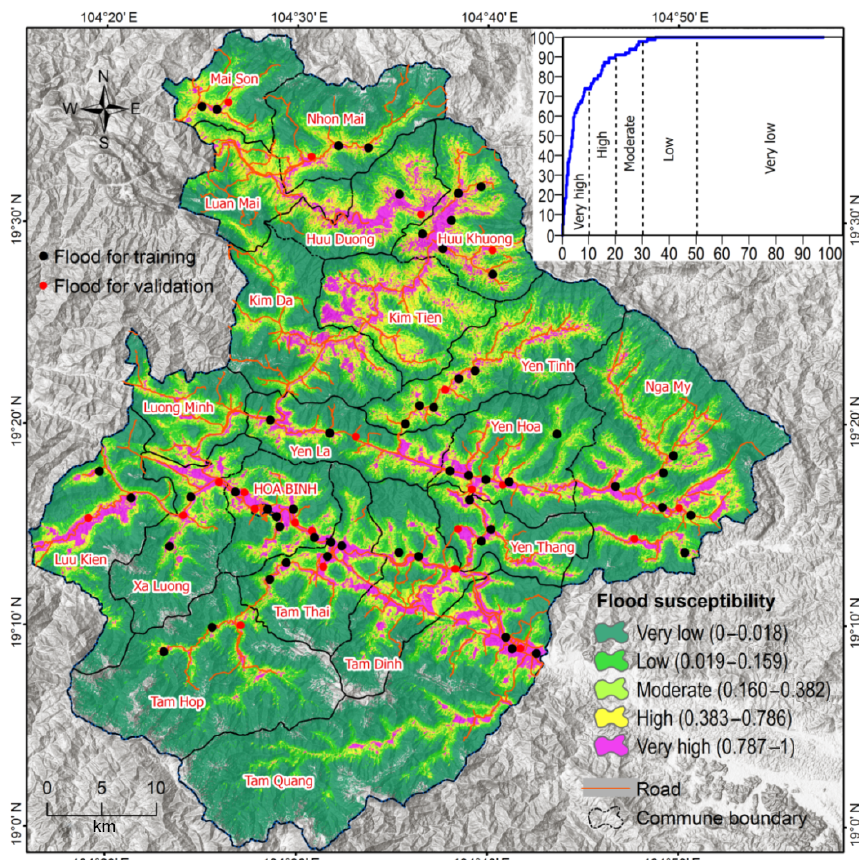
Figure 10. The flood susceptibility map using the proposed BayGmmKda model for the study